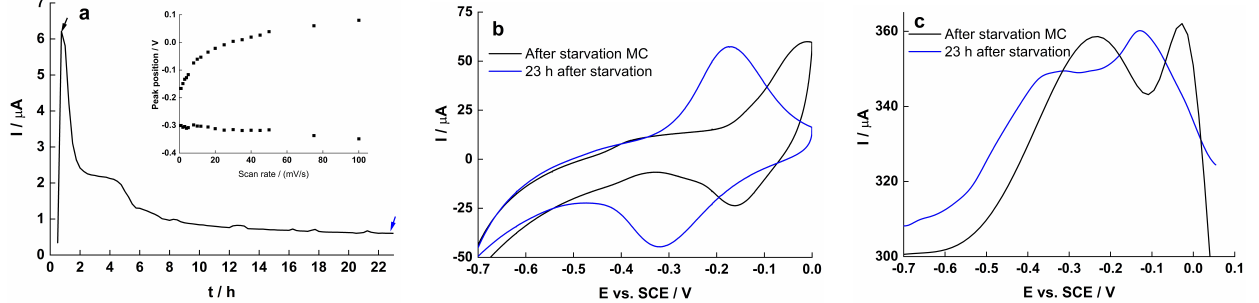
Figure 8. ( a ) CA with the relations of redox peak position vs. scan rate (inset); ( b ) CV and ( c ) DPV characteristics of early biofilm on RVC during